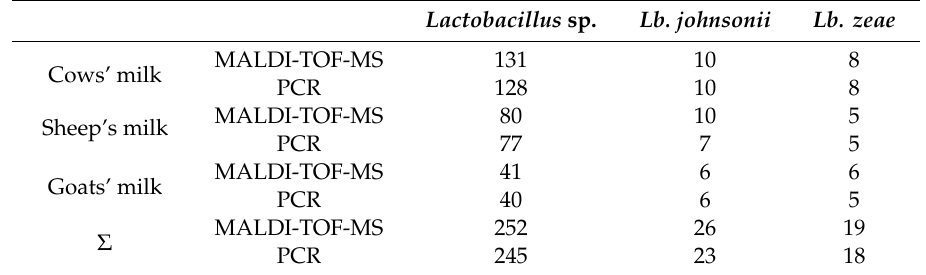
Table 2. The number of identified strains of Lactobacillus sp. and Lb. johnsonii and Lb. zeae species in milk